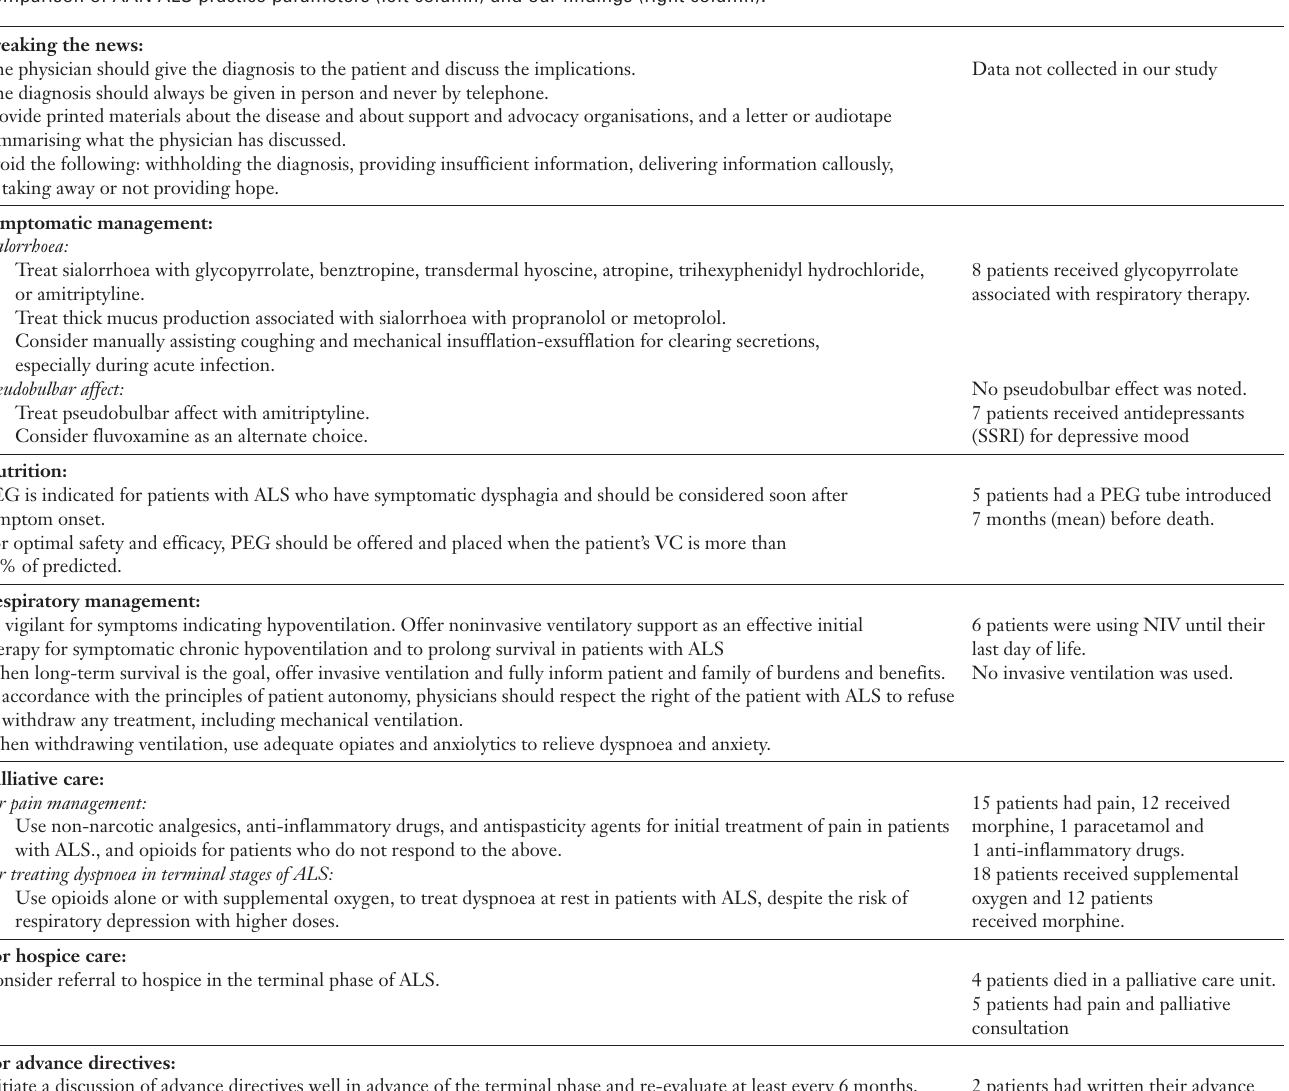
Comparison of AAN ALS practice parameters (left column) and our findings (right